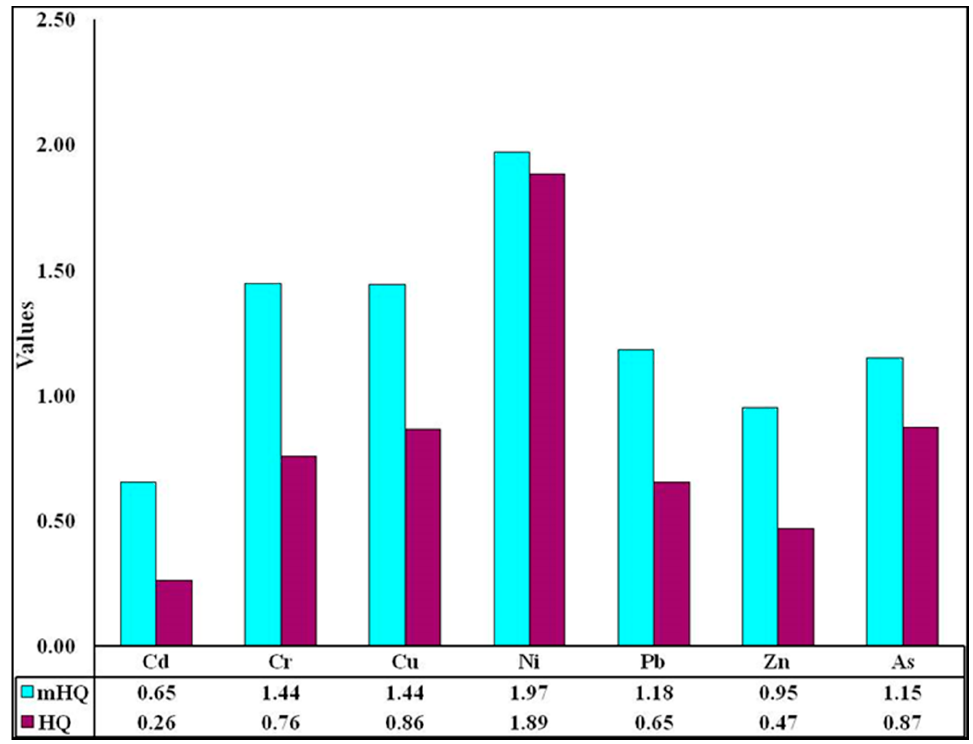
Figure 6. Potential ecological risks: Hazard Quotients (HQ) and modified Hazard Quotients (mHQ) associated with TEs.